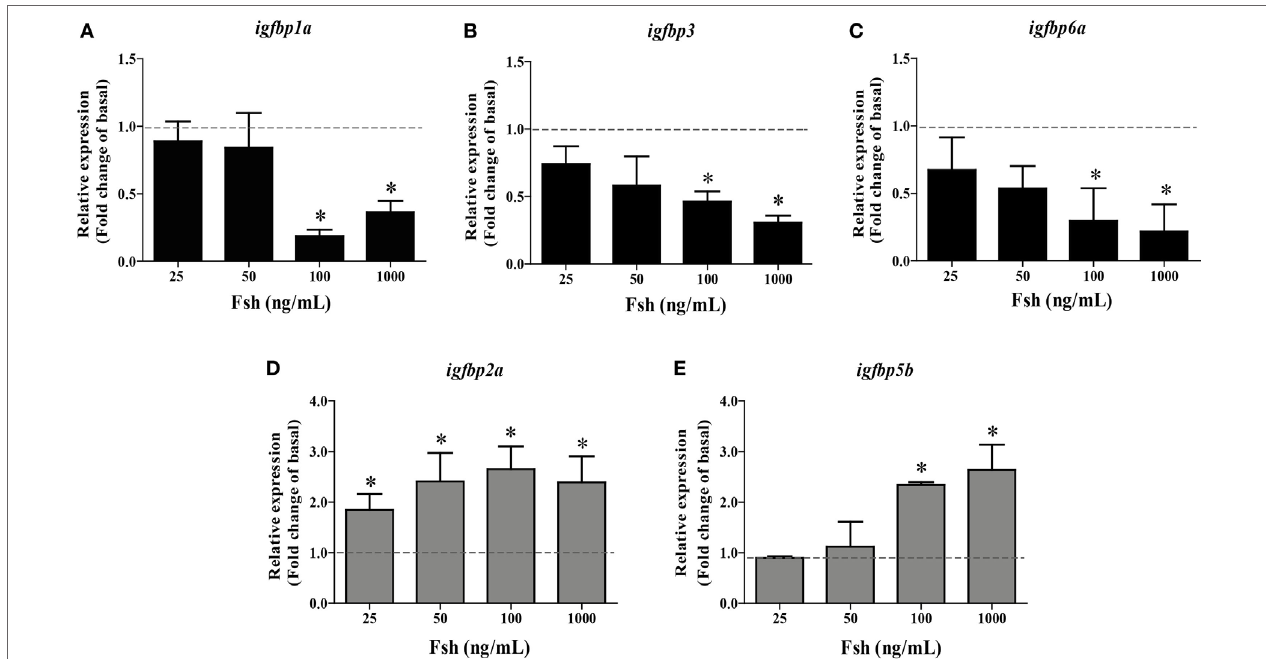
FigUre 1 | Follicle-stimulating hormone (Fsh) dose-response study on igfbp transcript levels in adult zebrafish testis after 5 days of primary organ culture. Fold-change of gene expression of igfbp1a (a) , igfbp3 (b) , igfbp6a (c) , igfbp2a (D) , and igfbp5b (e) under basal conditions (dotted line) or in the presence of 25,